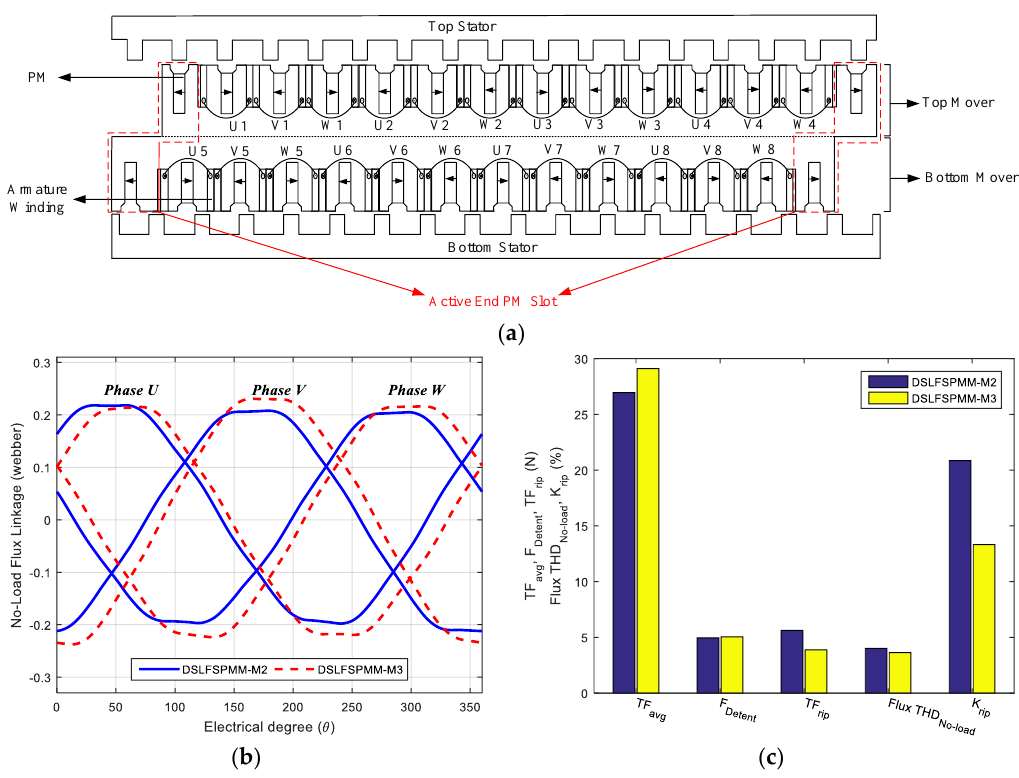
Figure 9. DSLFSPMM-M3: ( a ) 2D cross-sectional view of DSLFSPMM-M3; ( b ) Comparison of no-load flux linkage symmetry for DSLFSPMM-M2 and DSLFSPMM-M3; ( c ) Comparison of key performance indicators for DSLFSPMM-M2 and DSLFSPMM-M3. Table 4. Comparison of no-load flux linkage symmetry for DSLFSPMM-M2 with and without APMES. Parameter (Unit)